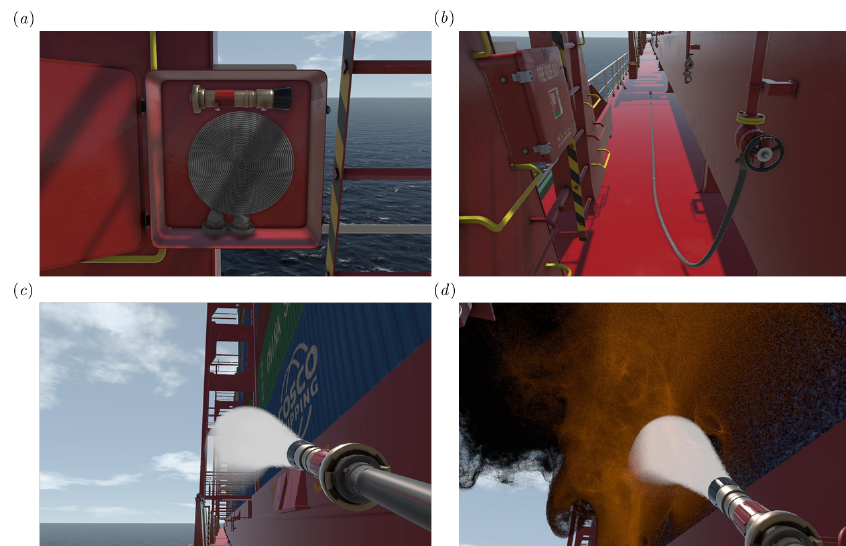
Figure 13. ( a ) The fire hose and fire hose nozzle; ( b ) the spread fire hose and fire hydrant; ( c ) the firefighter sprays water with the fire hose nozzle; ( d ) the firefighter sprays water on the container fire with the fire hose nozzle.